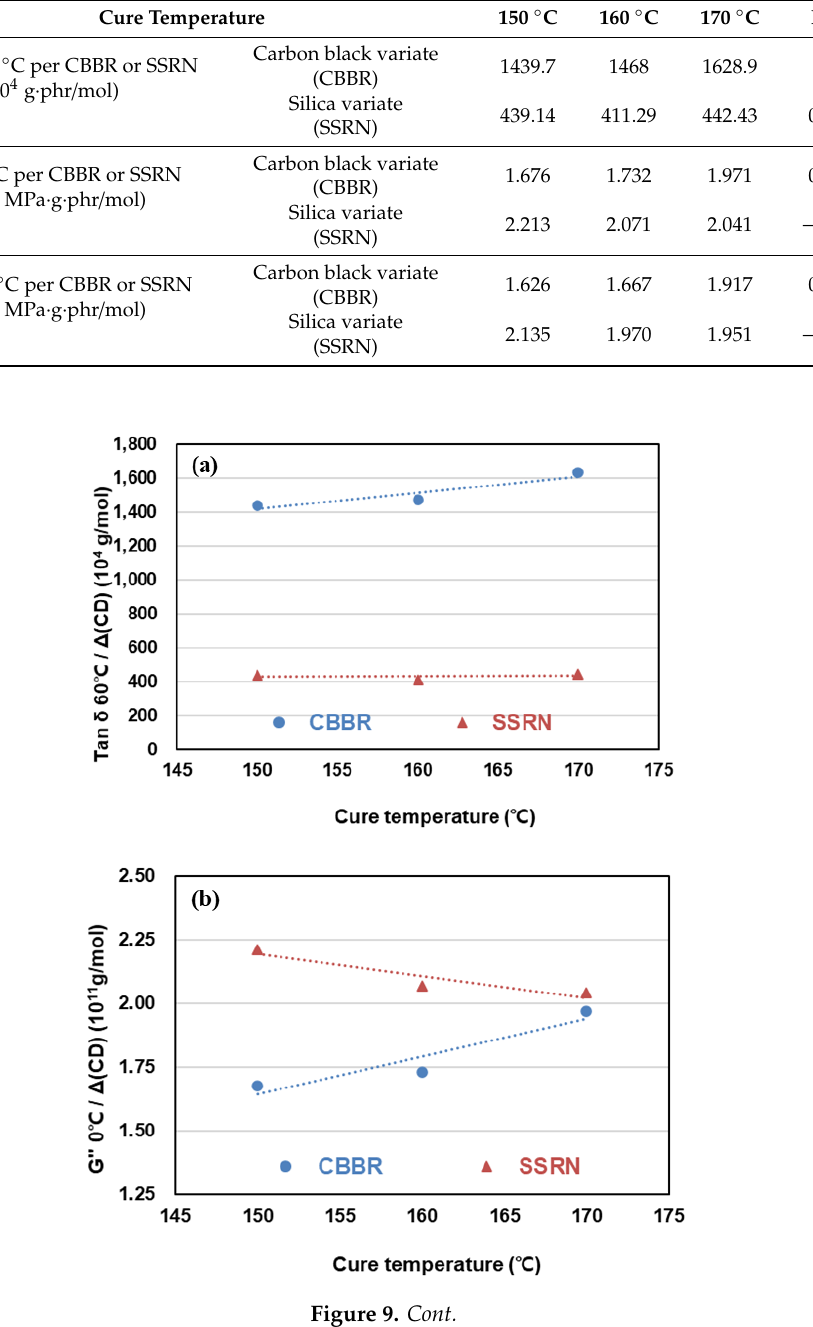
Figure 9. Change of viscoelasticity properties of the SBR binary filler compounds by different cure temperatures: ( a ) tan ẟ at 60 °C, ( b ) G ″ at 0 °C, and ( c ) G * at −20 °C. 4. Conclusions In this study, vulcanizate structures at different cure temperatures were categorized into CBBR, SSRN, and CCDS and quantified. The effect of each vulcanizate structure at different cure temperatures on the mechanical and viscoelastic properties was also investigated. CBBR is composed of a physical network between carbon black and rubber, while SSRN and CCDS consist of chemical